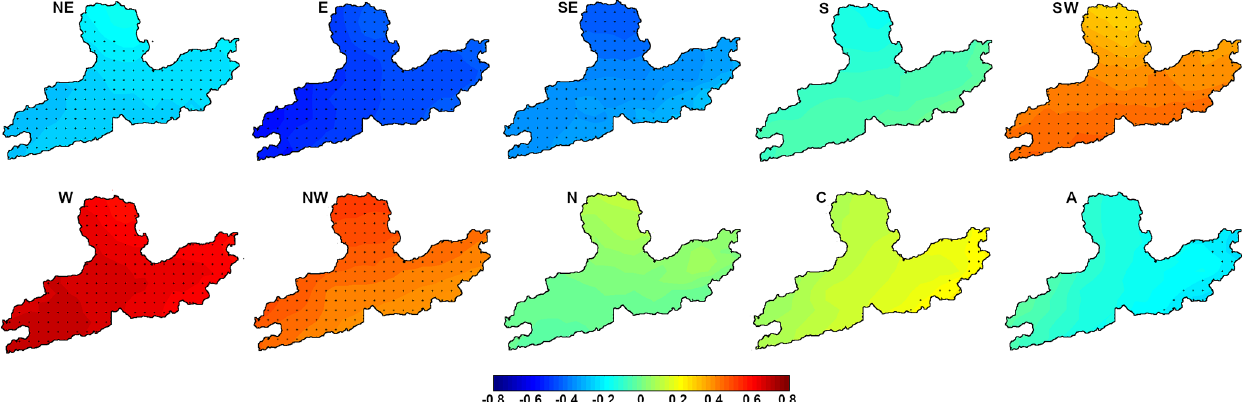
Figure 10. Spatial correlations between detrended grid series of the SPEI1 at a resolution of 0.1 ◦ in longitude and latitude and detrended monthly percentages of occurrence of each of the pure CWTs for 1980–2017. The dots in every correlation map denote statistically significant correlations at p < 0 . 05.